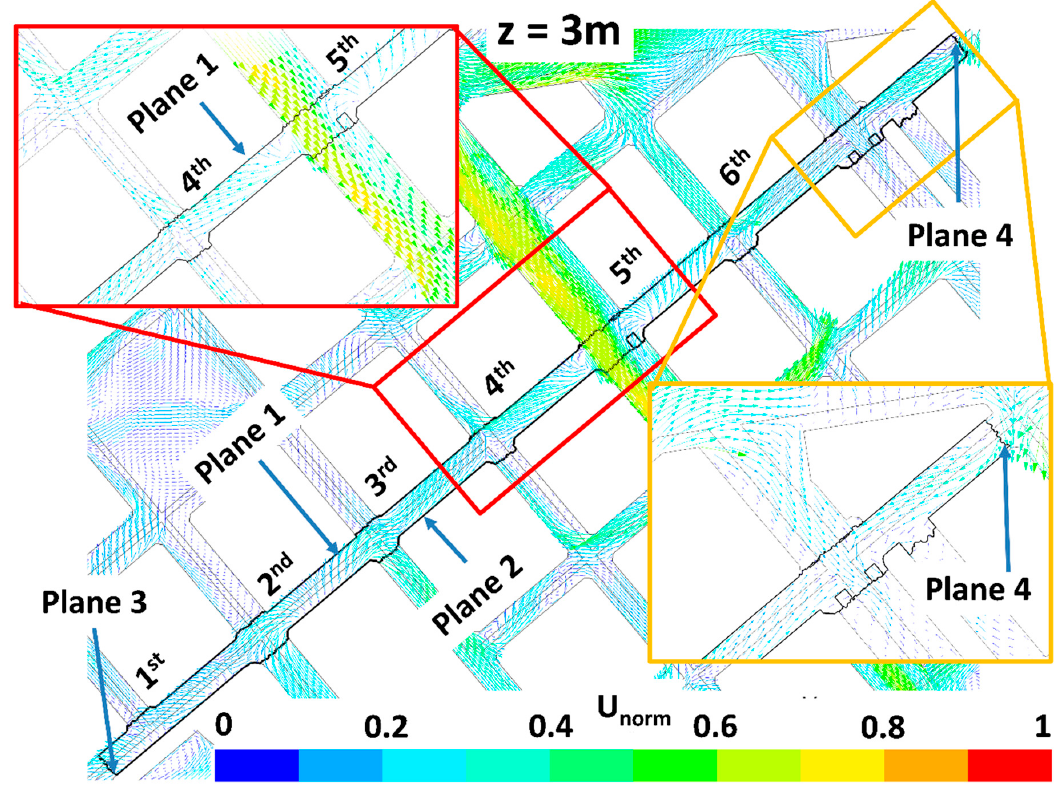
Figure 9. Same as Figure 6 but for the LAD05_NewTrees scenario.